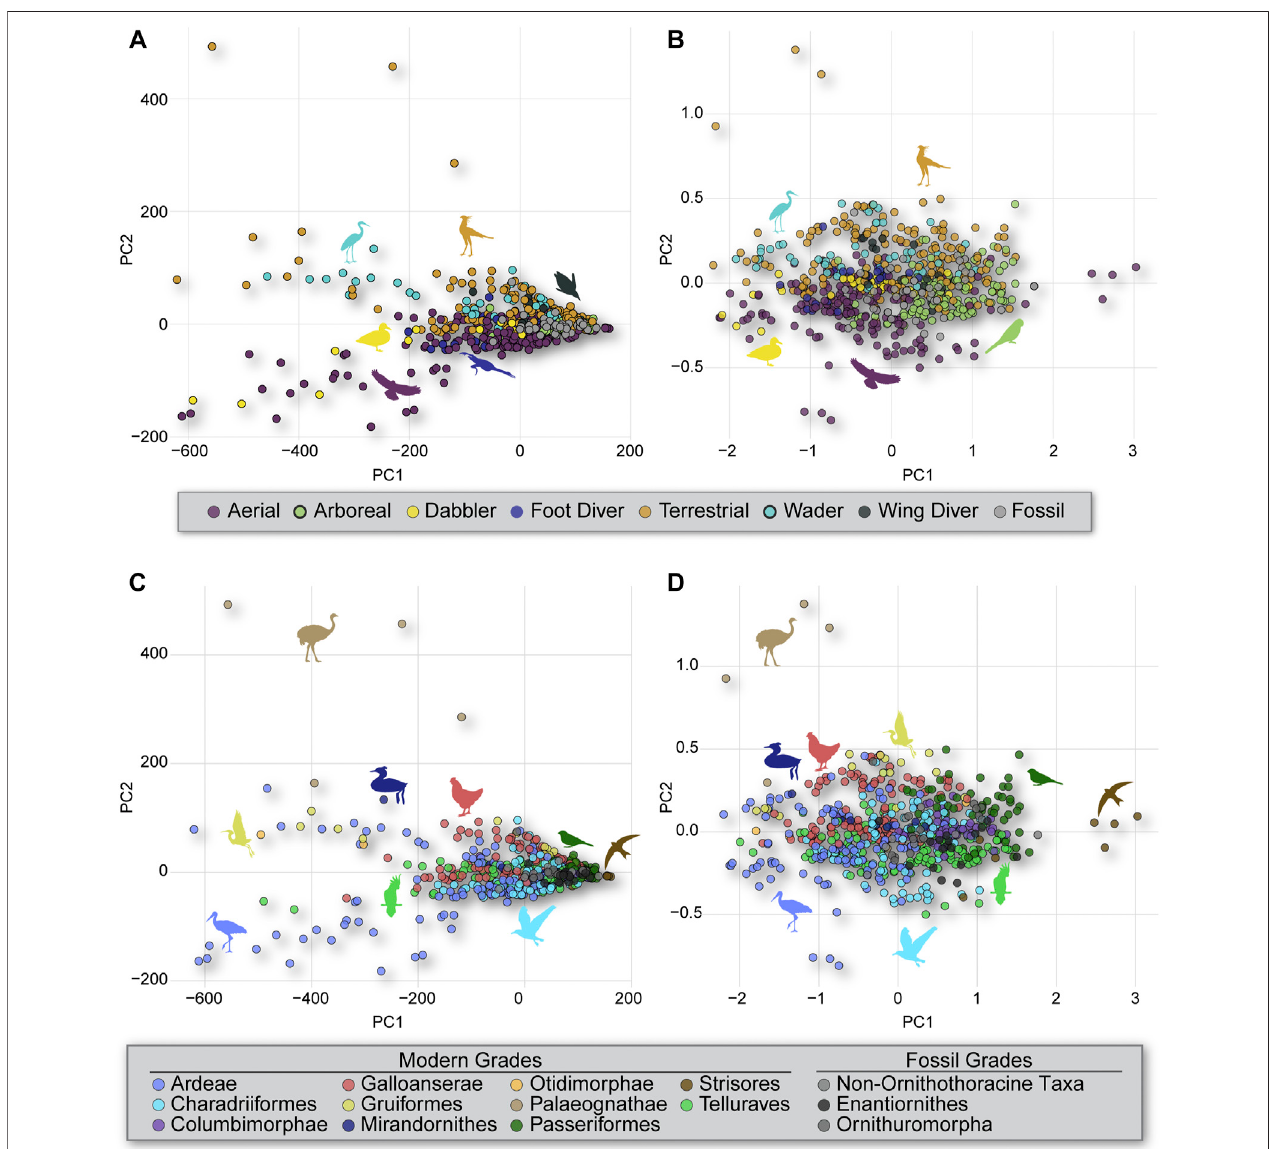
FIGURE 2 | PCA results of untransformed (A) and log 10 -transformed (B) morphometric data color-coded by foraging strategy. The same data color coded by clade, with untransformed (C) and log 10 -transformed (D) morphometric data. Notice how the raw data shown in (A,C) clearly display slope differences re fl ecting the scaling patterns between dimensions (PCs), whereas the log 10 -transformed data in (B,D) obscure those relationships.